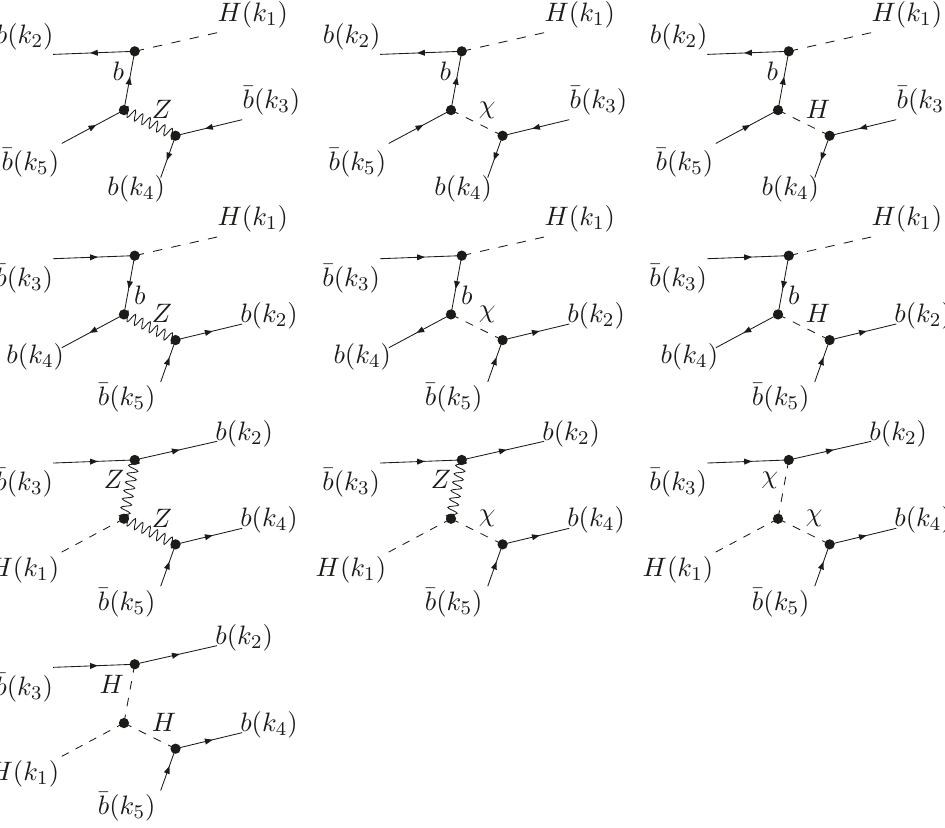
Figure 2 . Similar to (cid:12)gure 1 for Feynman diagrams of the Higgs boson decaying into four bottom quarks via electroweak